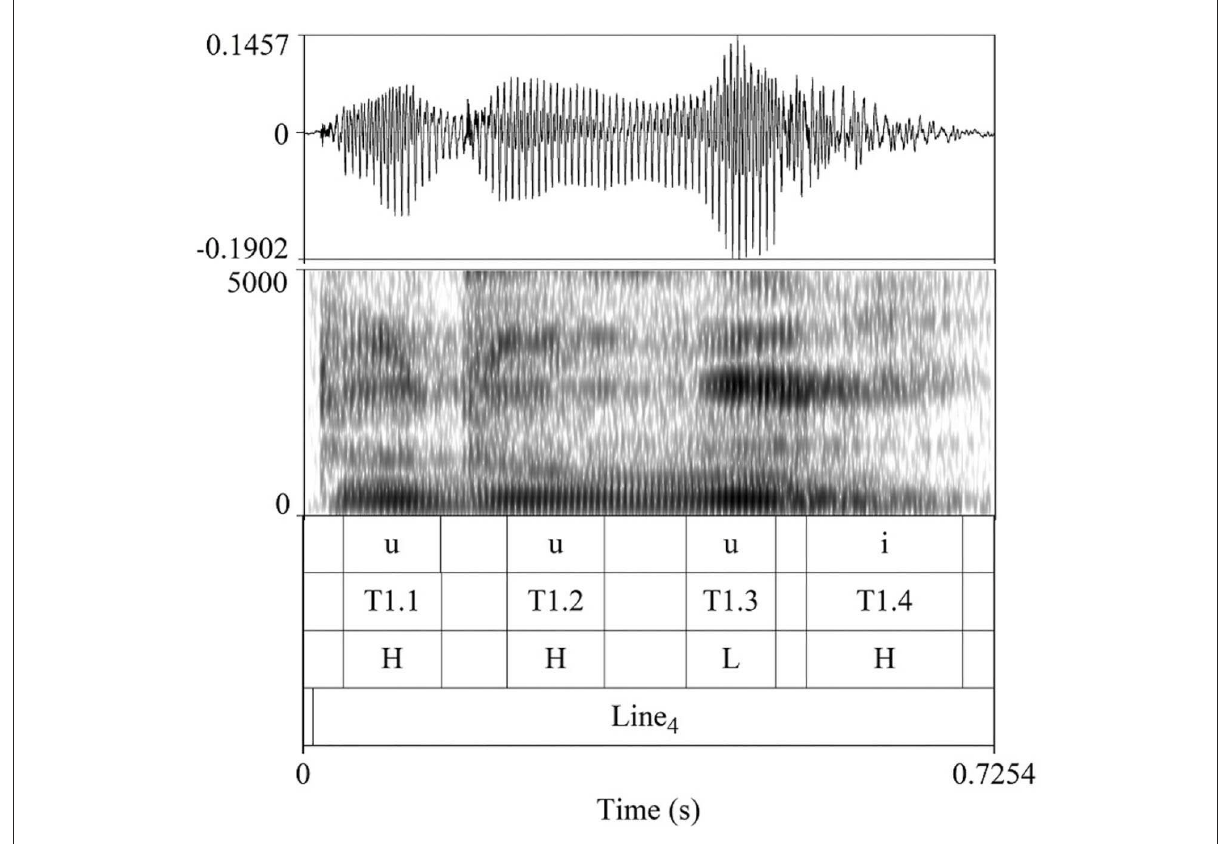
FIGURE1 Annotations of vowels, tones, tone-sequences, and poetic